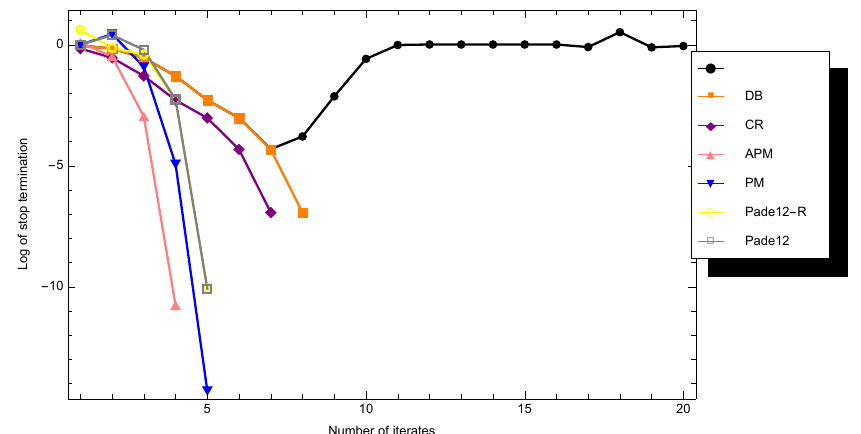
Figure 4. Numerical comparisons for finding the matrix square root in Example 1 when n = 100 at the top and n = 200 at the bottom.